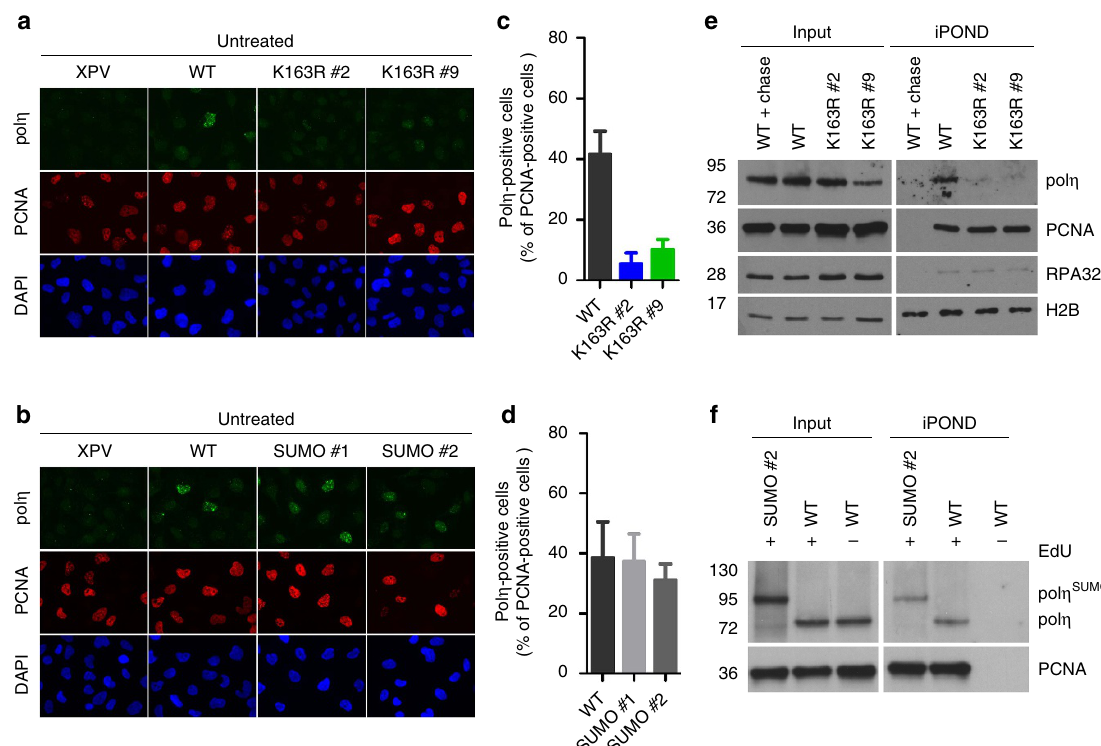
Figure 4 | SUMOylation of pol g is crucial for its recruitment at replication forks during unperturbed S phase. ( a , b ) Untreated XPV cells stably expressing pol Z WT , pol Z K163R or pol Z SUMO were fixed after extraction of soluble proteins and immunostained with pol Z and PCNA antibodies. Parental XPVcells were used as a negative control for pol Z staining. Representative images are shown (magnification (cid:2) 63). ( c , d ) The proportion of PCNA-positive cells presenting pol Z foci was assessed in three independent experiments (mean ± s.d.). At least 200 cells were counted per condition and experiment. ( e , f ) iPOND experiments were performed as described in Fig.